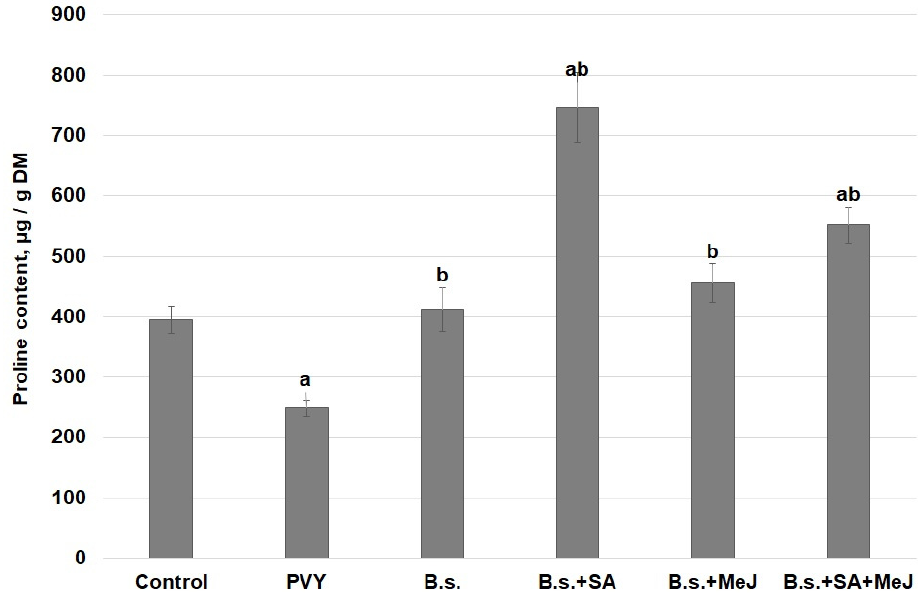
Figure 3. Effect of PVY infection and the mixture of B. subtilis with SA and MeJ application under soil water deficiency on proline content. Control—health plants; PVY—infected with PVY plants; B.s.— B. subtilis + PVY; B.s. + SA— B. subtilis + salicylic acid + PVY; B.s. + MeJ— B. subtilis + methyl jasmonate + PVY; B.s. + MeJ + SA— B. subtilis + salicylic acid + methyl jasmonate + PVY. a—indicates means that are statistically significantly different from the control, b—indicate means that are statisti- cally significantly different from the